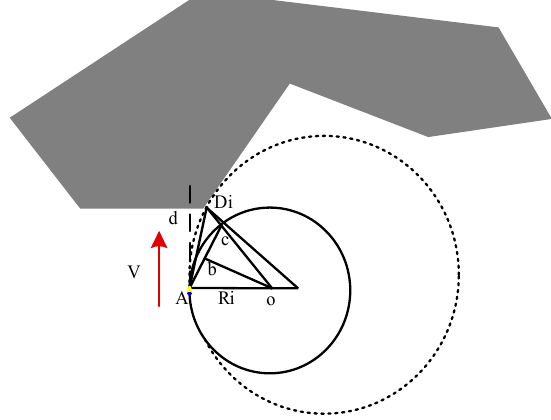
Figure 7. Expected maximum turning radius of the AUV obstacle avoidance point.